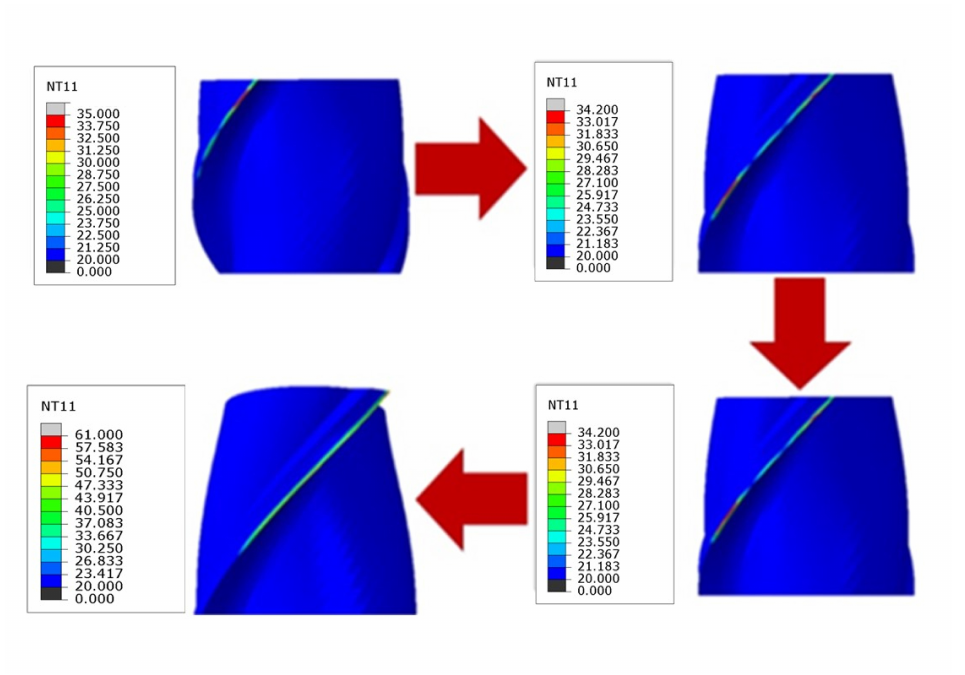
Figure 11. Simulation cloud diagram for cutting edge into workpiece.